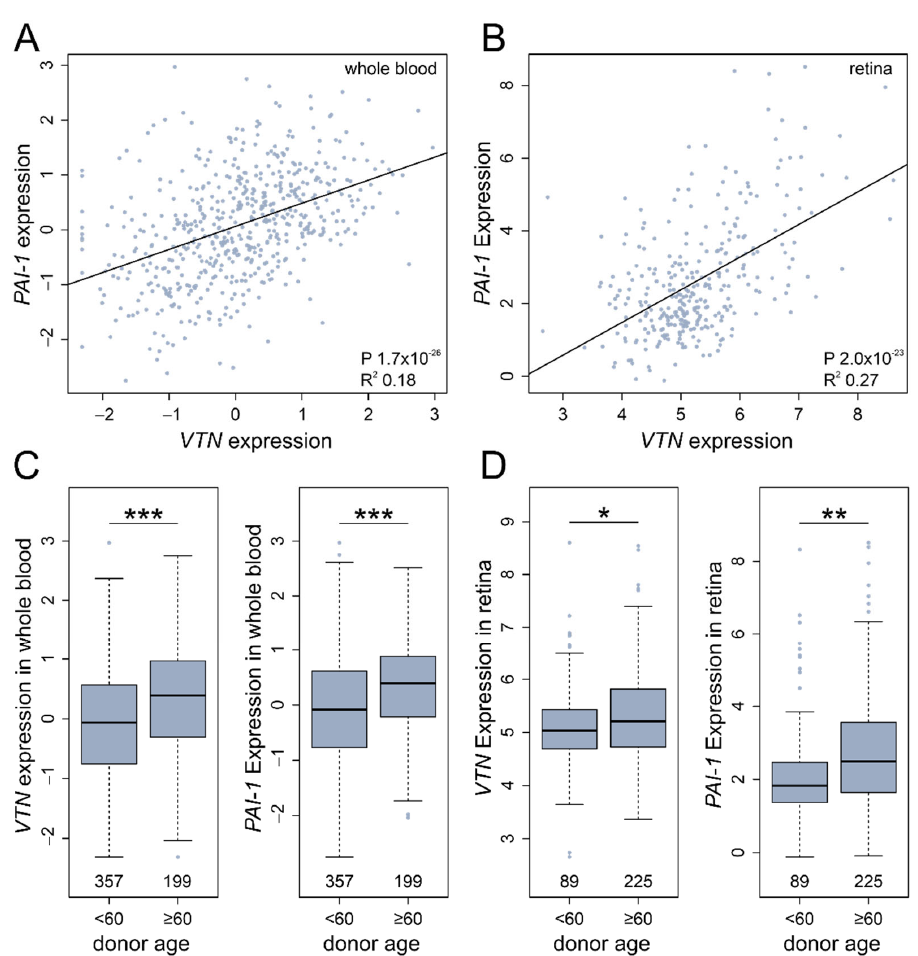
Figure 5. VTN and PAI ‐ 1 expression in whole blood and retinal tissue. Linear regression models were applied to analyze the relationship of VTN and PAI ‐ 1 mRNA gene expression in ( A ) whole blood and ( B ) retinal tissue. The 556 whole blood samples were derived from European donors in the GTEx dataset and underwent several normalization steps, as described in [20,21]. The analysis in retina was based on 311 healthy retina samples, as described in [22]. ( C ) Gene expression of 357 whole blood samples retrieved from donors below the age of 60 and 199 samples from individuals at or over 60 years of age. VTN and PAI ‐ 1 were significantly upregulated in the older cohort (Mann– Whitney U test, * p < 0.05, ** p < 0.01, *** p < 0.001). ( D ) Similar effects, although less pronounced, were obtained in gene expression analyses of retinal